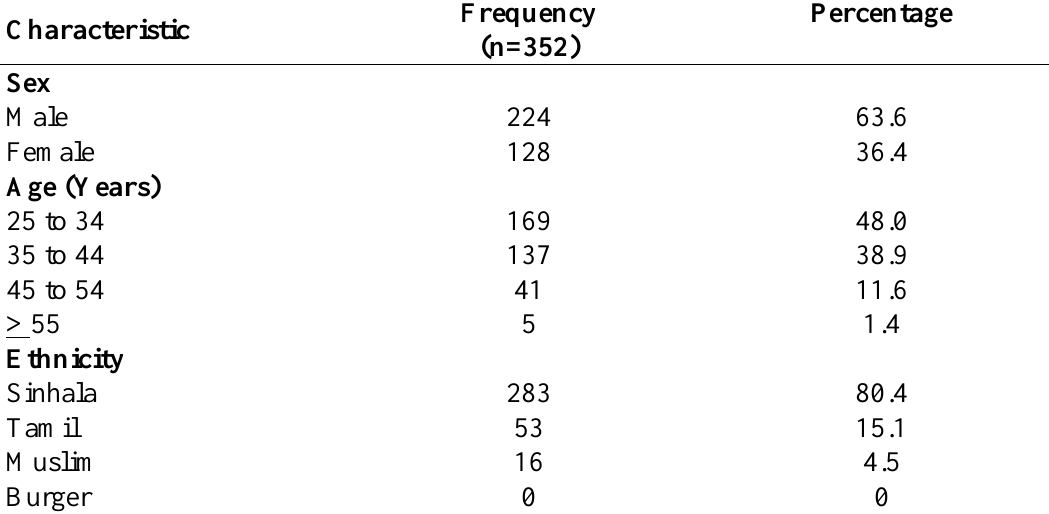
Table 1-Distribution of demographic characteristics of the study population